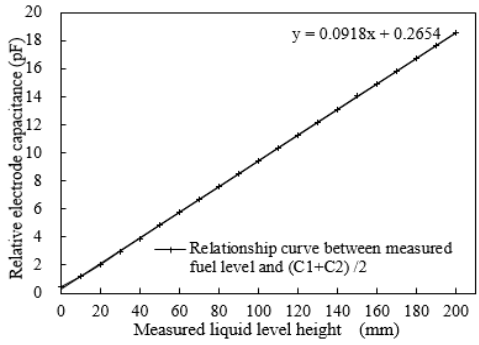
Figure 5. Characteristic curve of liquid level and output average capacitance.